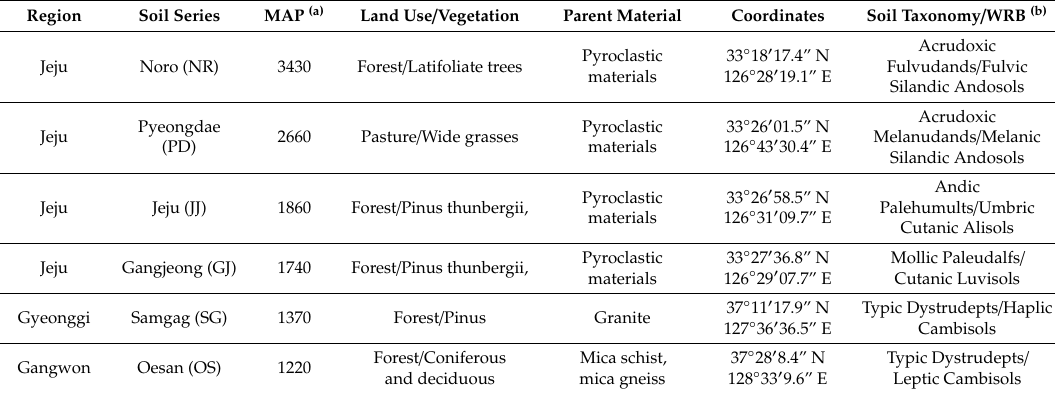
Table 1. Site characteristics of six soil profiles.